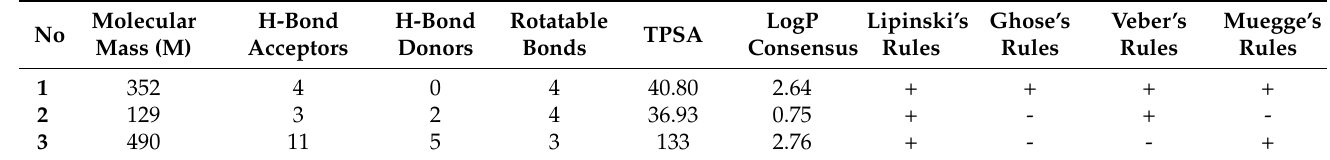
Table 3. The molecular descriptor and parameters of Lipinski’s, Ghose’s, and Veber’s rules for pal ‐ matine ( 1 ), metformin ( 2 ) & glimepiride ( 3 ) data here .